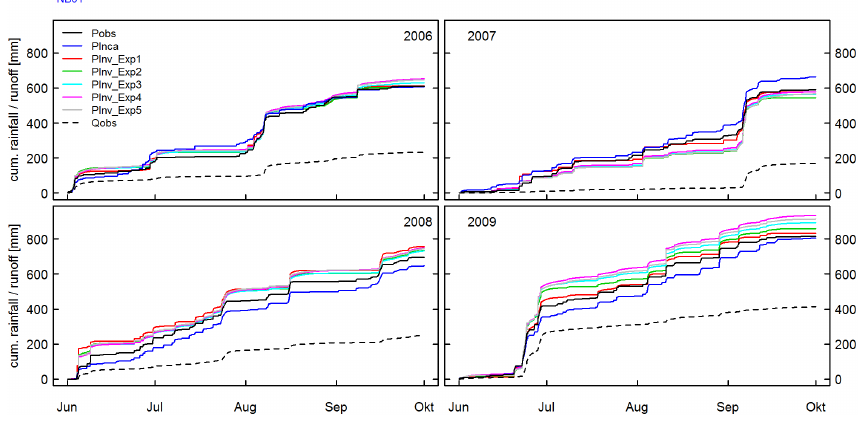
Figure 8. Schliefau catchment: cumulative rainfall curves for observed rainfall ( P obs ), INCA rainfall ( P Inca ) and the inverse rainfall of